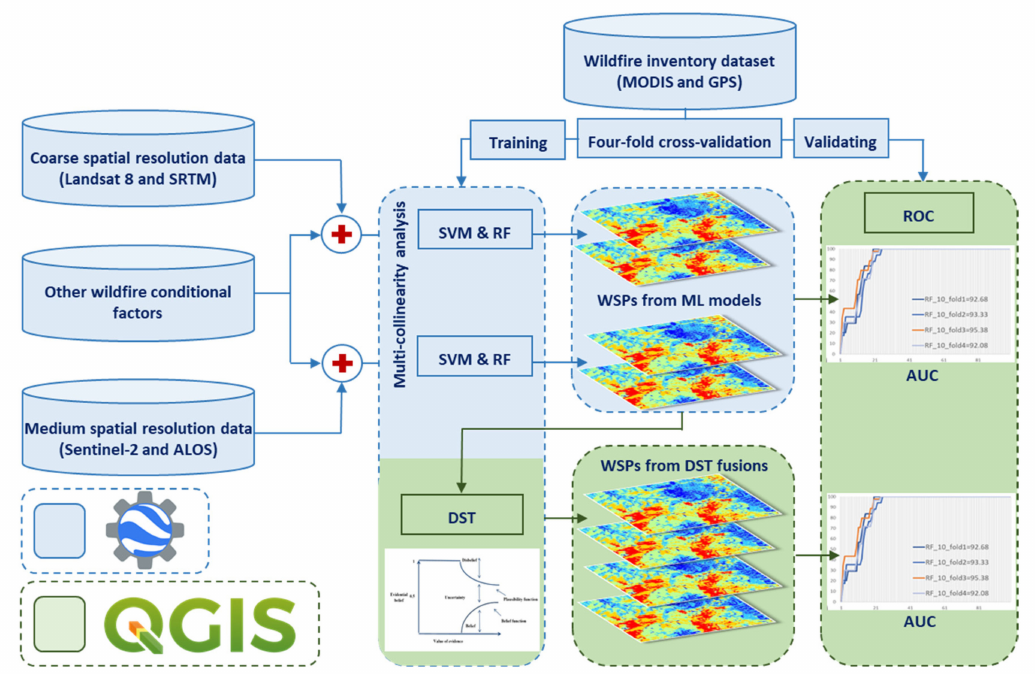
Figure 1. The flowchart represents a summary of the integrated approach. The data preparation, preprocessing, multi-collinearity analysis, training of the applied machine learning models of the support vector machines and random forest, and the wildfire susceptibility prediction maps were performed in Google Earth Engine illustrated with the blue color. QGIS software was used to apply the Dempster–Shafer theory for data fusion, WSP optimization, and accuracy